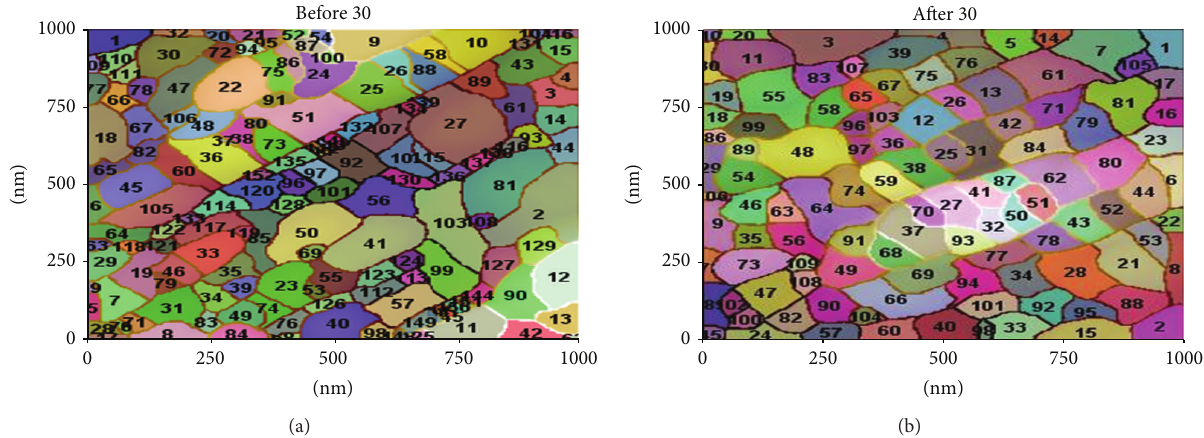
Figure 5: (a) The grain boundaries of the film for untreated TiO 2 via ultrasonic process. (b) The grain boundaries of the film for treated TiO 2 via ultrasonic